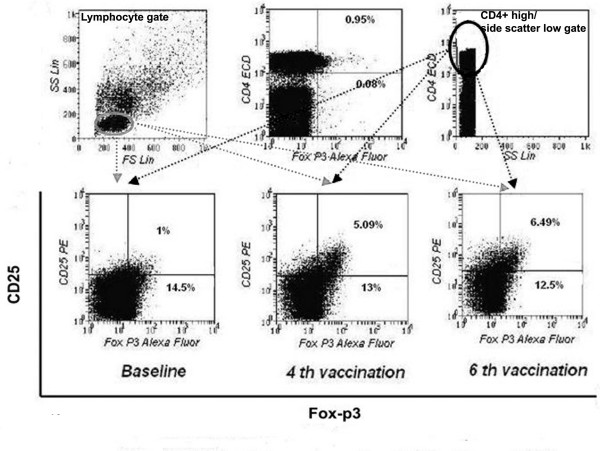
Representative flowcytometry plots of CD4+CD25+foxp3 high (T regs). T regs from patient L001, tracked through vaccination. Data shown are for baseline and just prior to the 4th and 6th vaccinations; 200,000 events were acquired and analysed.